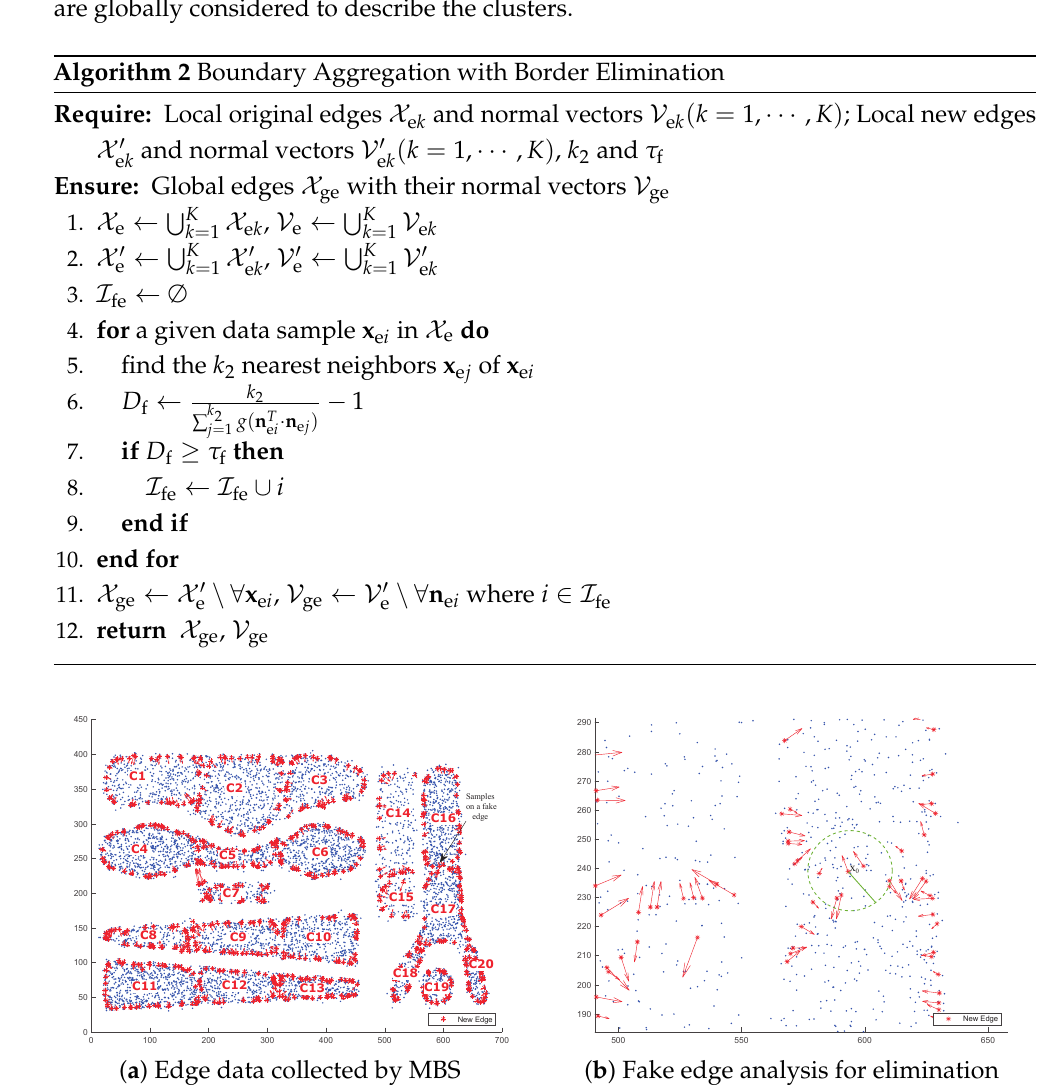
Figure 3. Fake edge analysis for elimination based on the convergence directions of a data sample’s five nearest neighbors. The data set used is Chameleon [16], with eight irregular clusters after noise elimination by [17]. Here, MBS is conducted, with K = 10, k 1 = 30, γ l = 0.85, and γ u =